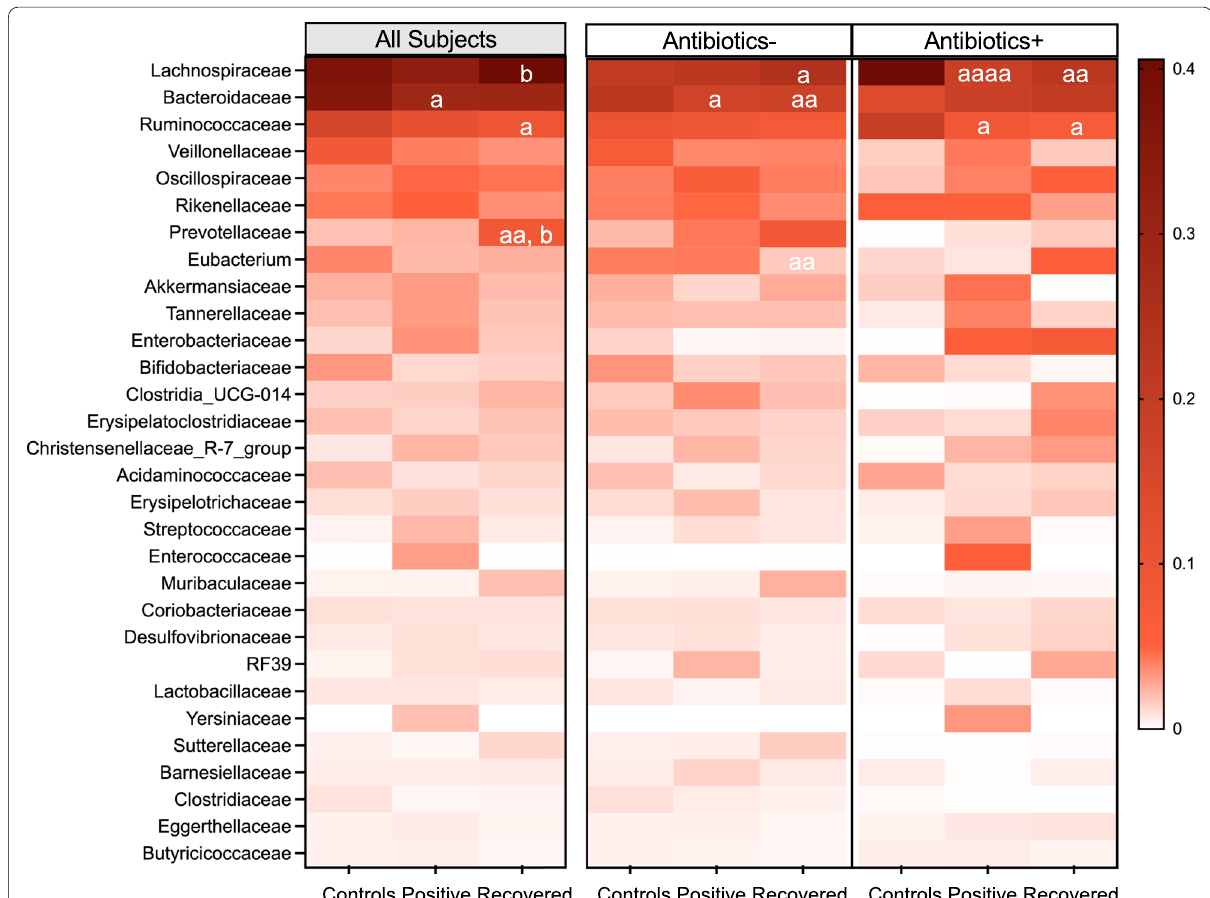
Fig. 3 Heatmap of gut microbial compositions in the three groups of study subjects that varied in COVID-19 infection status. The relative abundances of the 30 most abundant bacterial taxa at the family level were compared between the Controls (n 20), COVID-19-positive (n 20), = = and COVID-19-recovered patients (n 20) (left panel). Additional comparisons were performed in subjects without (center panel) or with recent = antibiotic use (right panel). Table 1 indicates the number of subjects in each group. Left panel: statistical significance was assessed for comparisons to all Controls ( a ) or to all COVID-19-positive patients ( b ). For particular taxa: a p < 0.05, b p < 0.05, and aa p < 0.01, by two-way ANOVA. Right panel: p -values are shown for comparisons to the Controls ( a ) only between subjects of the same antibiotic use status. Bacterial communities in the COVID-19-positive and COVID-19-recovered patients did not differ substantially, as determined by two-way ANOVA. For particular taxa: a p < 0.05, aa p < 0.01, and aaaa p < 0.0001, by two-way